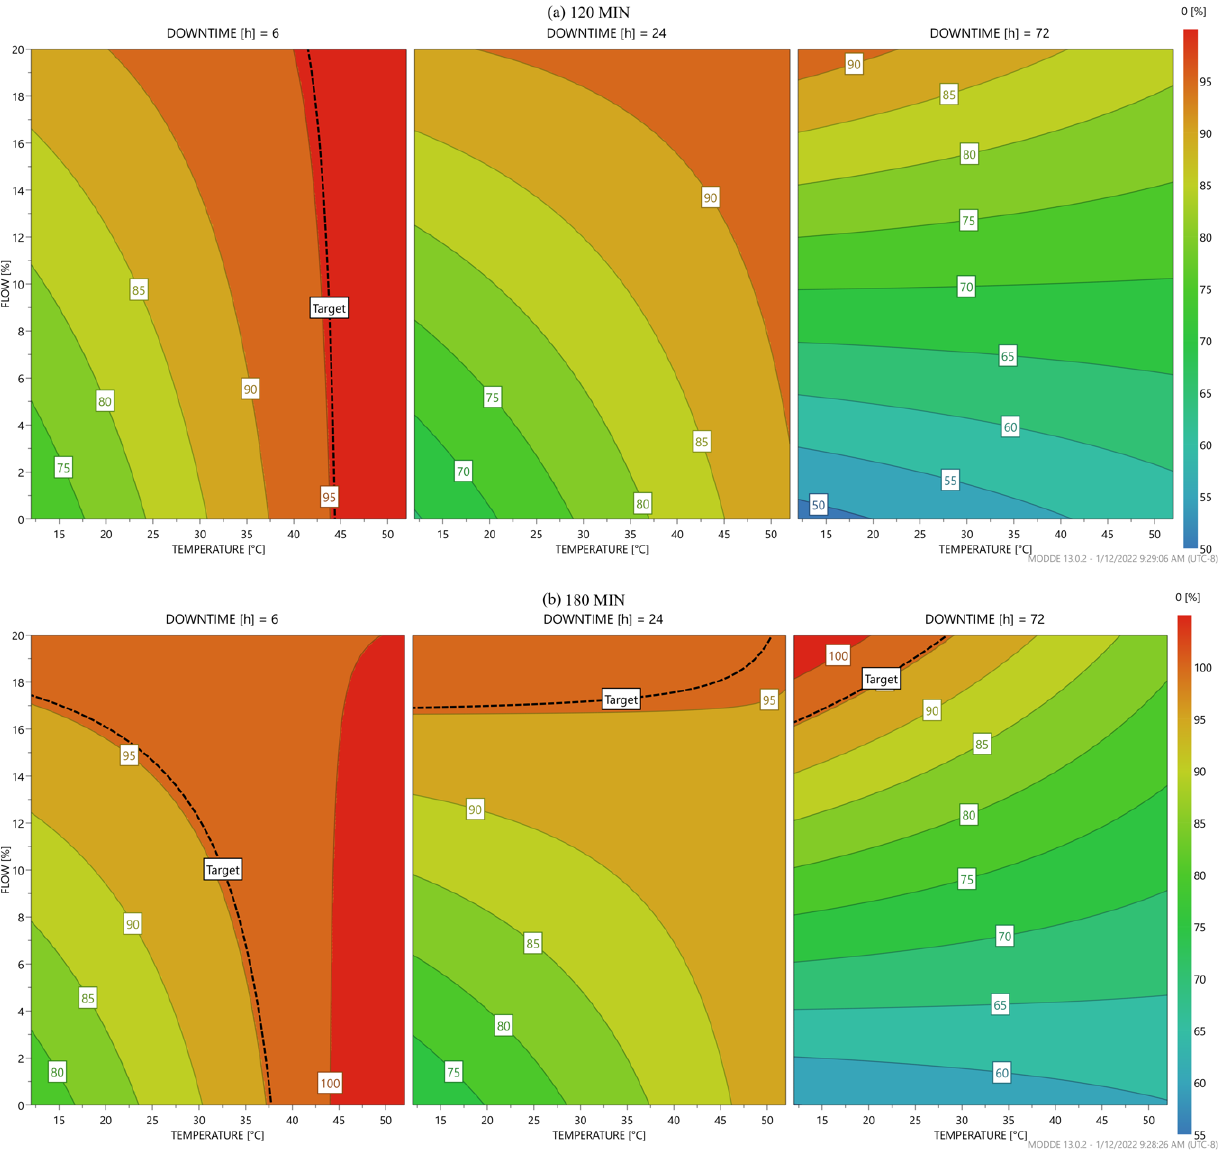
Figure 4. CH 4 -% in product gas in relation to the effect of the parameters set during downtime lengths for three specific times after initiation of refeeding strategy. The contour plots are divided into three graphs for each downtime length; left graph (6 h), middle graph (24 h) and right graph (72 h). (–) Target product gas quality of 95.4% CH 4 . Product gasses are shown for periods of ( a ) 120 min after initiating the refeed of the BTFs; ( b ) 180 min after initiating the refeed of the